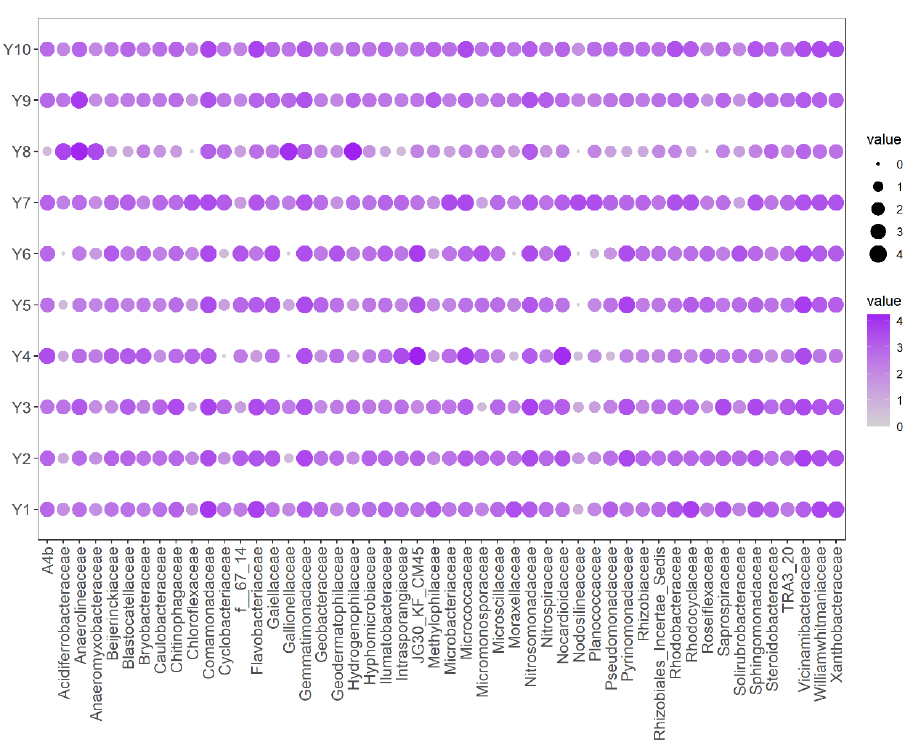
Figure 4. The relative abundance of the top 50 bacteria at the family level. The values in the figure were calculated as follows: log10(bacteria abundance × 10 5 ).